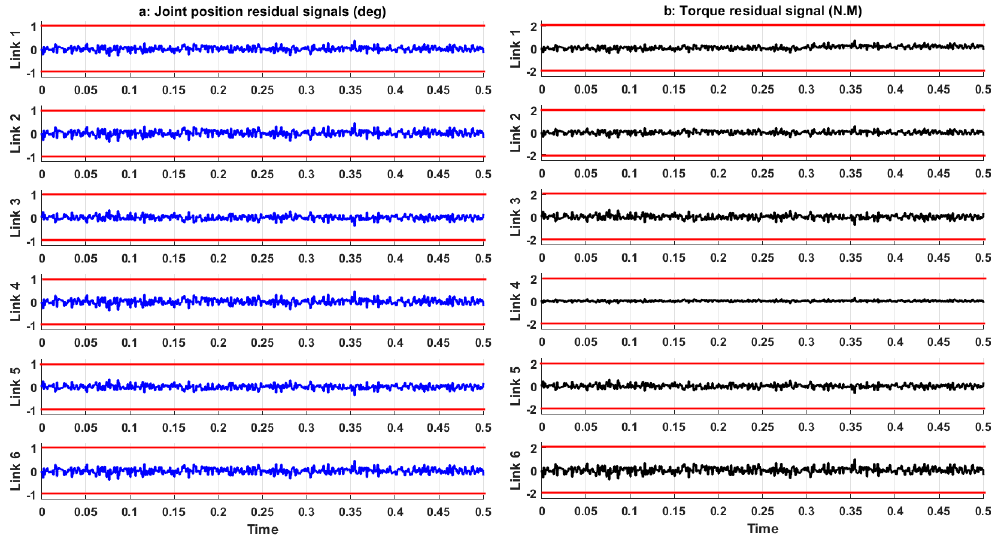
Figure 10. Residual signals in the normal condition: ( a ) Joint variable residual signals and ( b ) torque residual signals.